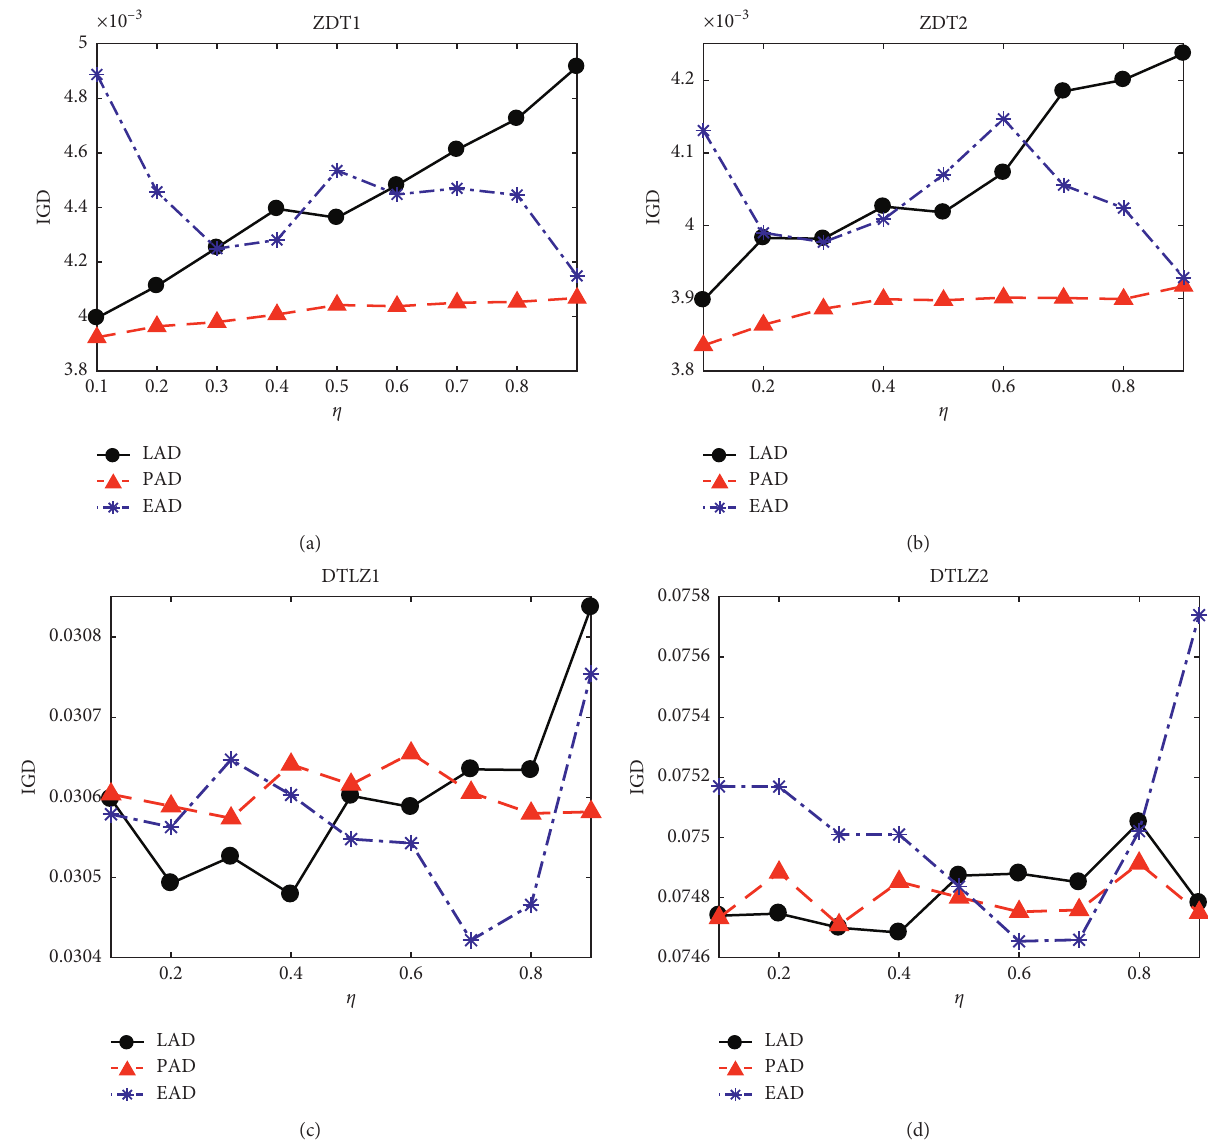
Figure 2: The values of IGD changed by η